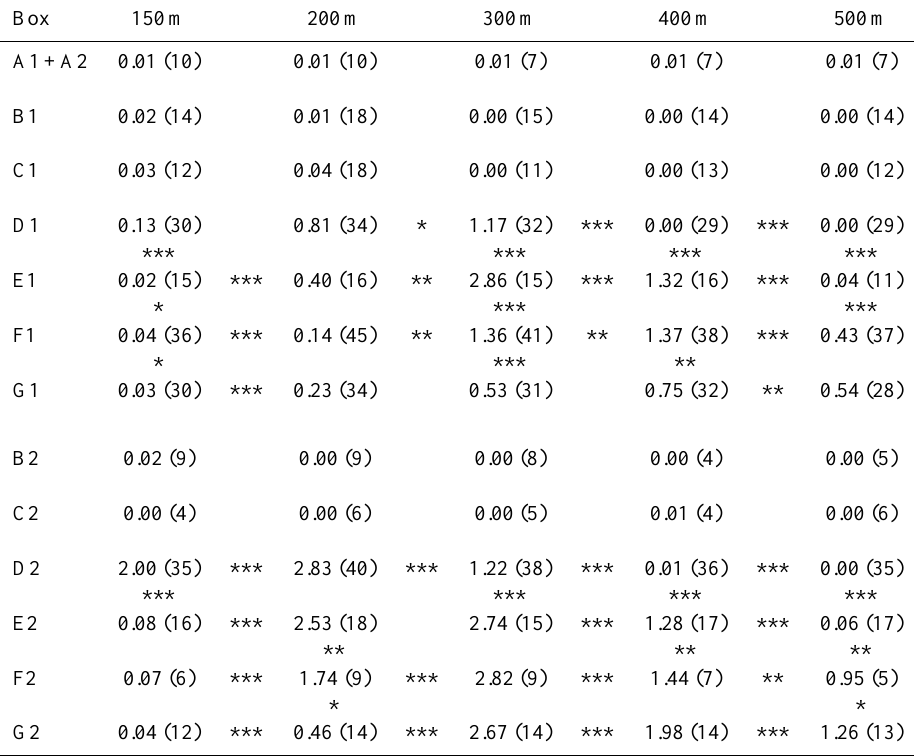
Table 2. Median NO − concentrations (µM) for all boxes near the indicated depths (number of values in parentheses; data in Table S.1.b). 2 One-sided p for NO − difference between adjoining medians in boxes D–G: * ≤ 0.20; ** ≤ 0.10; *** ≤ 0.05; blank, non-significant (see also 2 footnote in Table